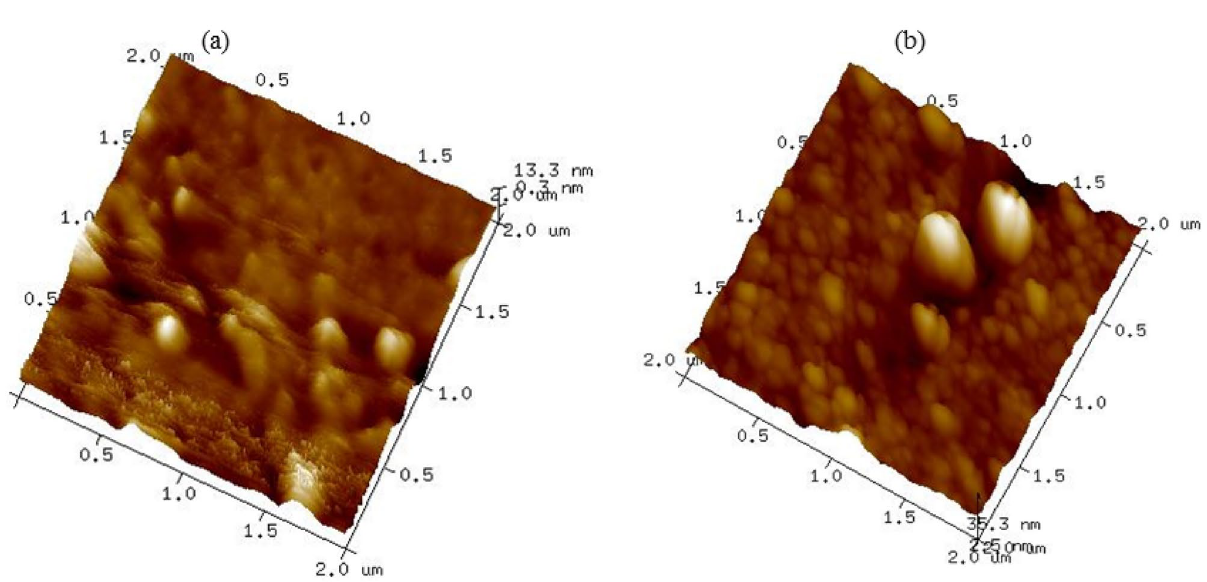
Figure 10. AFM images for (a) PS/pTAP (50%/50%) composite blend membrane, and (b) PS/pTAP (40%/60%) composite blend